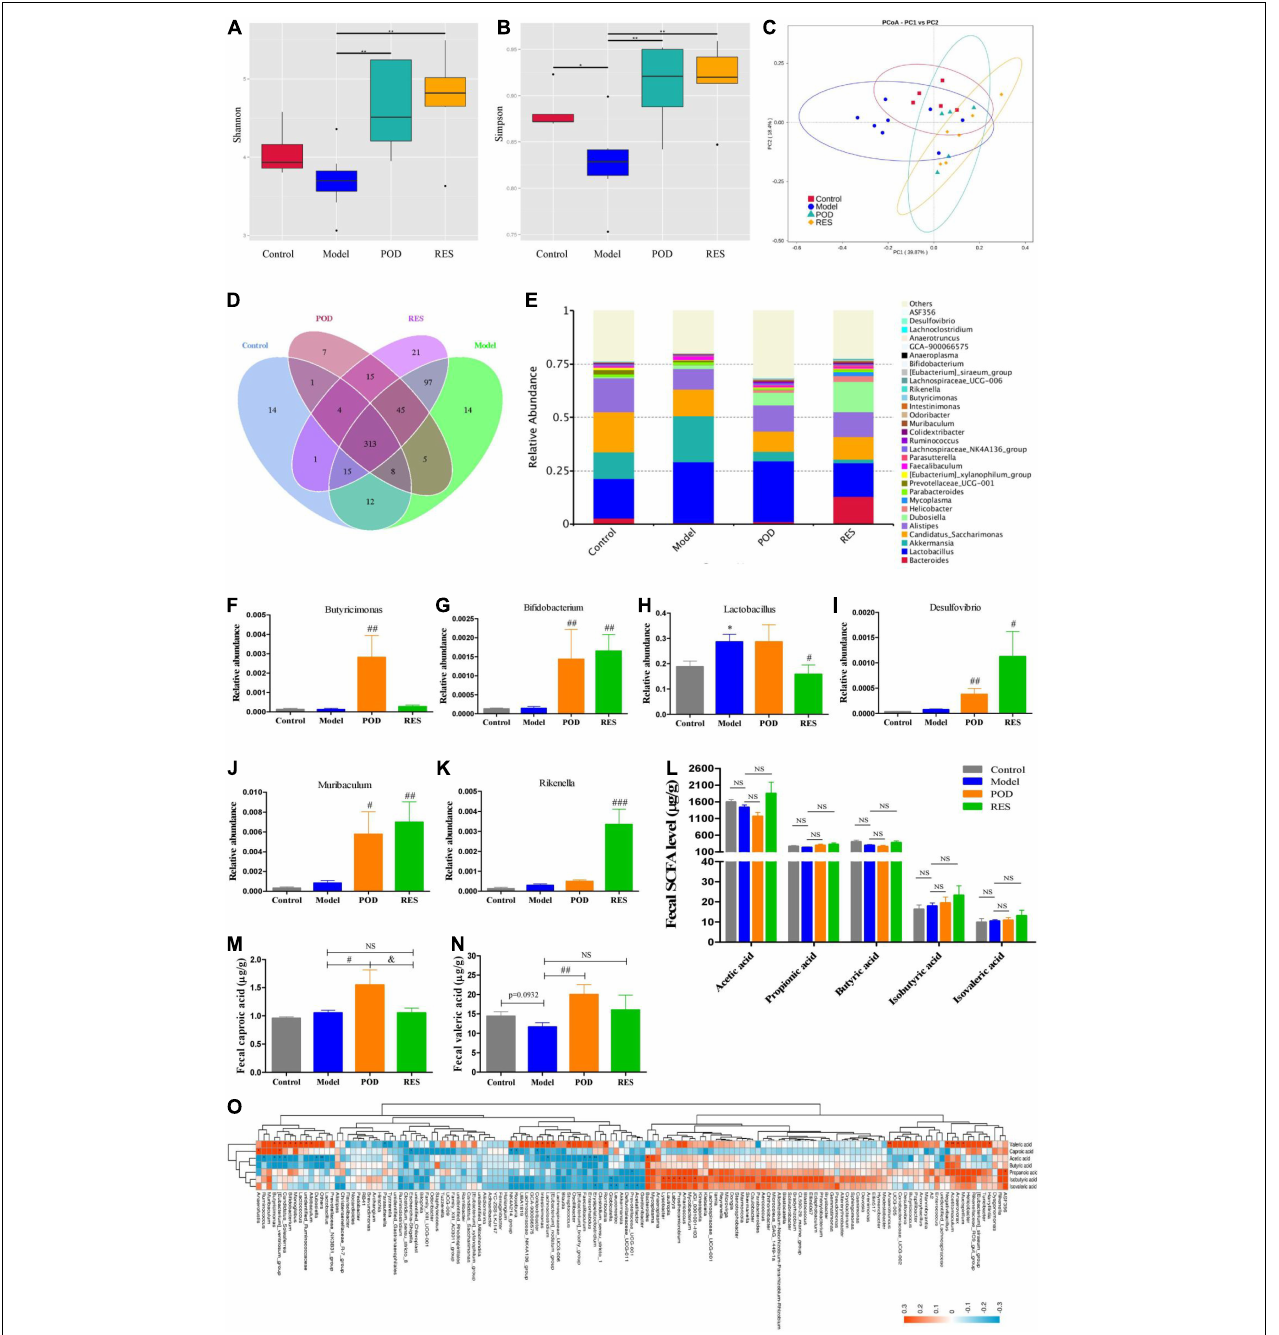
FIGURE 5 | Microbiome and SCFAs of the fecal samples. Alpha-Diversity was presented by a box plot of the Shannon (A) and Simpson (B) . (C) Principal coordinate analysis (PCoA) plot analysis. (D) Petal analysis of OTU. (E) Relative abundance of gut microbiota at the genus level (top 30). (F–K) Relative abundance of the altered microbiota. (L–N) Levels of SCFAs. (O) Correlation analysis of SCFAs level and gut microbiota abundance at the genus level. Data are presented as mean ± SEM. Orange, positive correlation. Blue, negative correlation. ∗ p < 0.05, ∗∗ p < 0.01, compared to control group. # p < 0.05, ## p < 0.01, ### p < 0.001, compared to model group. & p < 0.05, compared to POD group. NS, p >